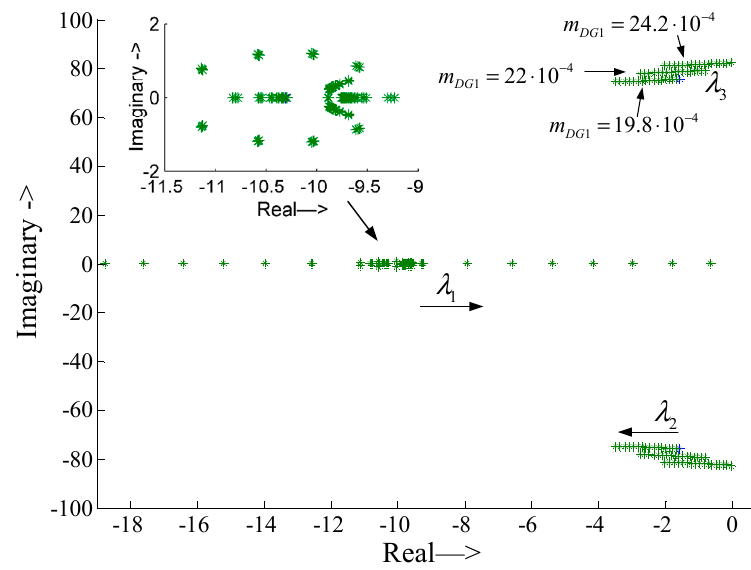
Figure 17. Dominant eigenvalues of a MG when 19.8 × 10 − 4 ≤ m ≤ 24.2 × 10 − 4 , 0 ≤ n ≤ 1.3 × 10 − 3 .